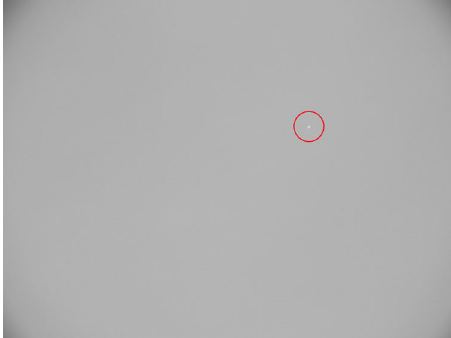
Fig. 5 Visualization of a rocket body during daylight. Sunlight re fl ections of an SL-12 rocket body (NORAD ID: 15772) displaying a fi eld of view of 0.21°× 0.16°. The image was captured with an ASI 1600 on 2018/12/04, 14:31 UTC at a sun elevation of 5°. A red circle highlights the rocket body for easier